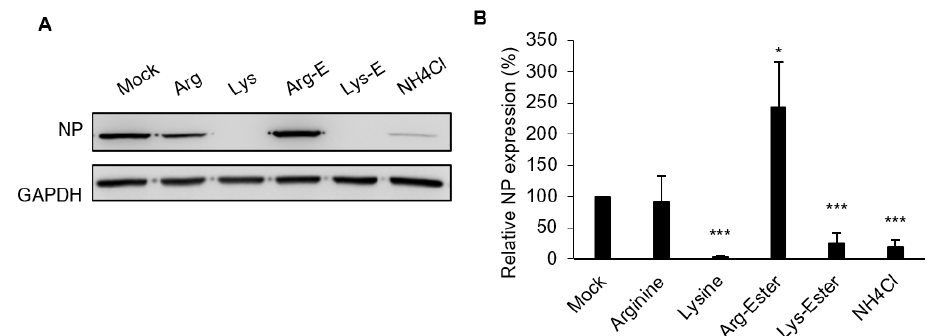
Figure 4. Compound effects on IAV infection in A549 cells. A549 cells were pre-treated with differ- ent concentrations of the compounds for 1 h and infected with IAV for 6 h in the presence of the compounds in the media. Cells treated with the medium were used as Mock control. ( A ) Cell lysates were harvested for Western blotting using anti-IAV NP antibody. GAPDH was used as a loading control. ( B ) Total RNA was extracted and used for RT-qPCR analysis. The levels of viral RNA were normalized with GAPDH RNA. The concentrations of the compounds were 10 nM, except for NH 4 Cl, 20 mM. The values represent the means ± standard deviation (SD) of data from three independent experiments. *, p < 0.05; and ***, p < 0.001 compared with controls (n=3).